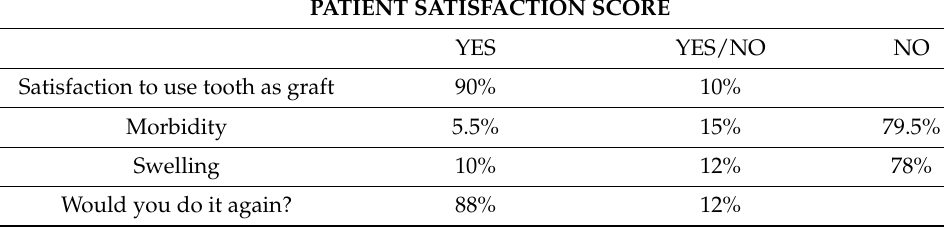
Table 3. Patient’s satisfaction schedule